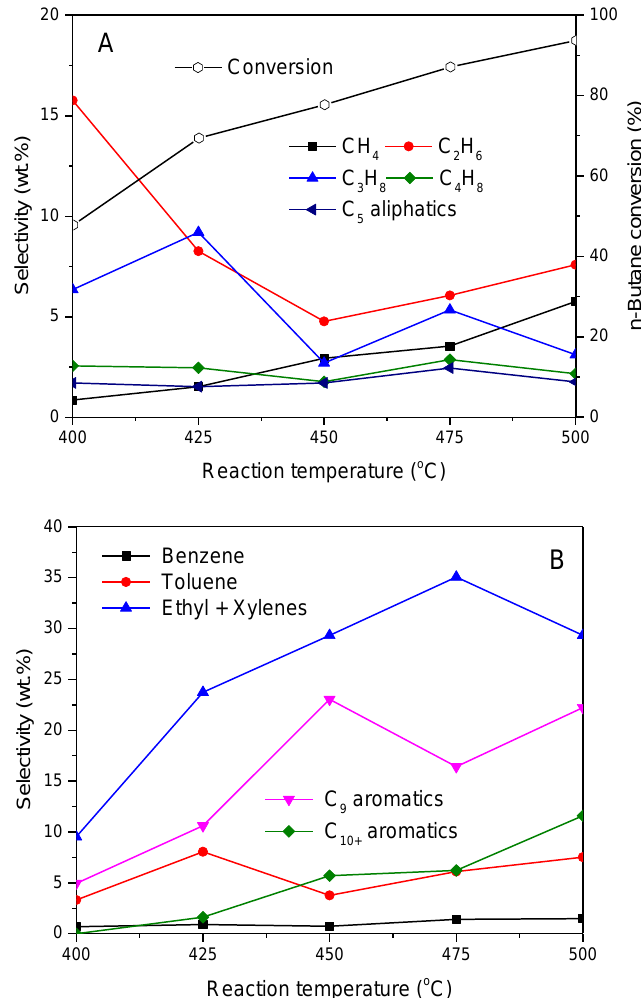
Figure 8. Effect of reaction temperature on n-butane conversion, selectivity to aliphatics ( A ), and selectivity to aromatics ( B ) over Pt Mo BM. The C 5 H 10 in aliphatics and C 10 H 14 in aromatics were used to simplify the molar calculations for the C 5 aliphatics and C 10+ aromatics.